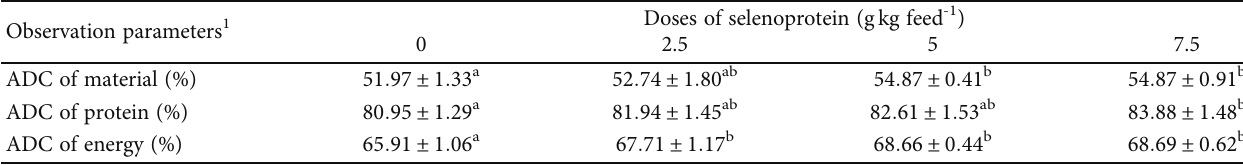
Table 2: Digestibility performance of whiteleg shrimp after being given treatment feed.